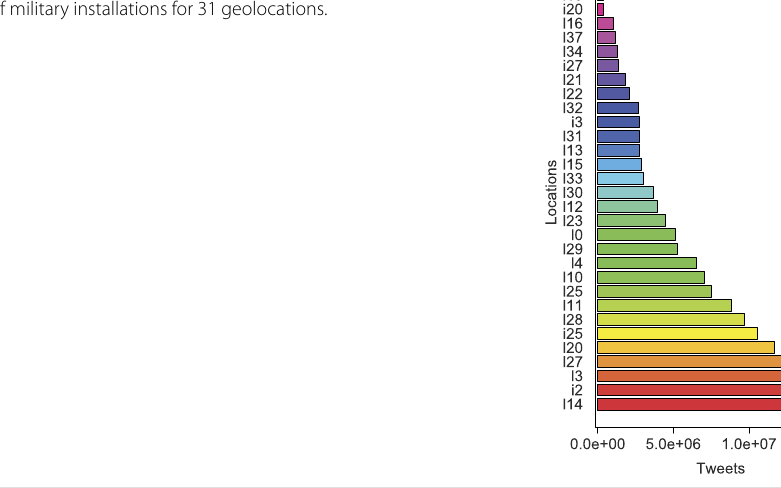
Figure 1 Twitter dataset statistics across 31 military locations. The number of tweets collected within a 25-mile radius of military installations for 31